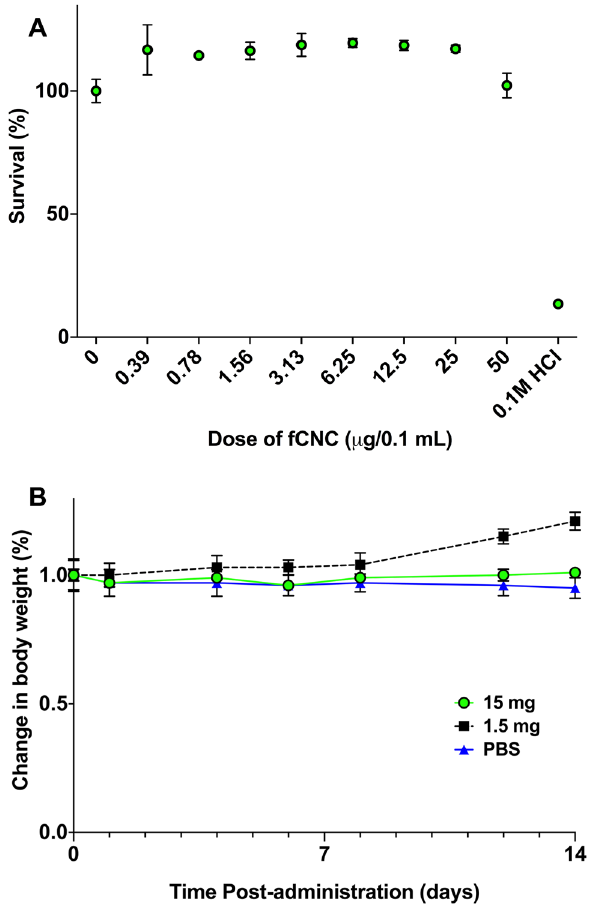
Figure 7. Biocompatibility and safety of fCNC (A) in vitro and (B) in vivo. There was no evidence of human kidney epithelial cell toxicity arising from treatment with fCNC in vitro. Cell viability did not decrease across a range of fCNC doses. The fCNC was biocompatible and safe in naïve mice as indicated by absence of weight loss upon treatment. There was no signs of lethargy or absence of grooming noted in these